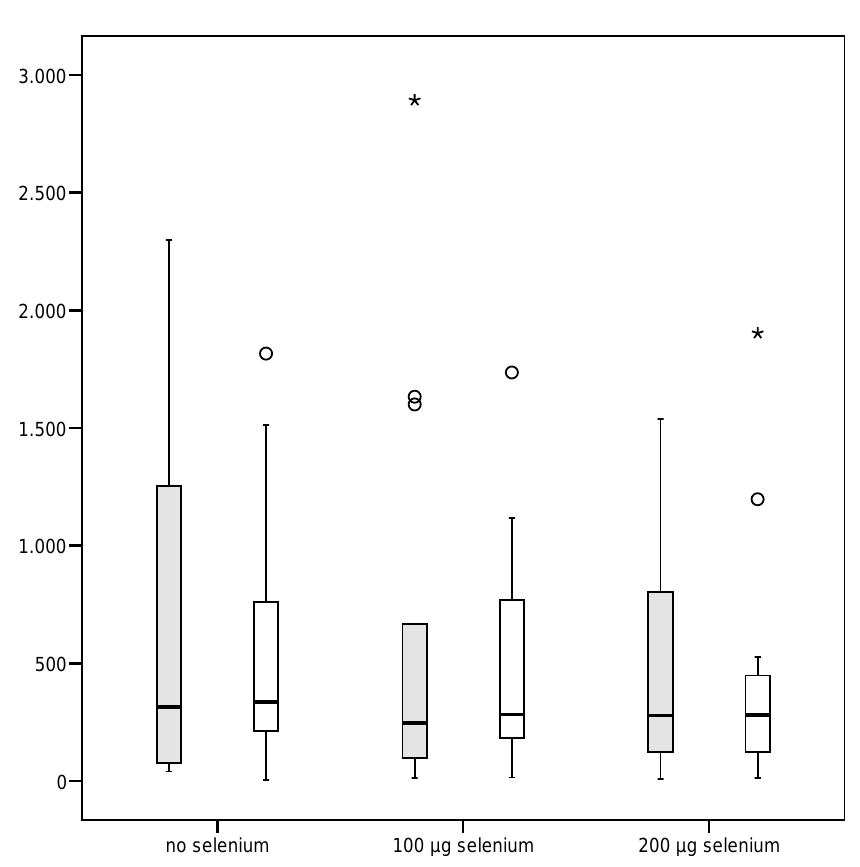
FIGURE 1. Boxplot (median, first, and third quartile, whiskers 3 rd /97 th percentile) showing TPO Ab titers [U/ml] at diagnosis and after 12 months. The change in TPO Ab titers is statistically not